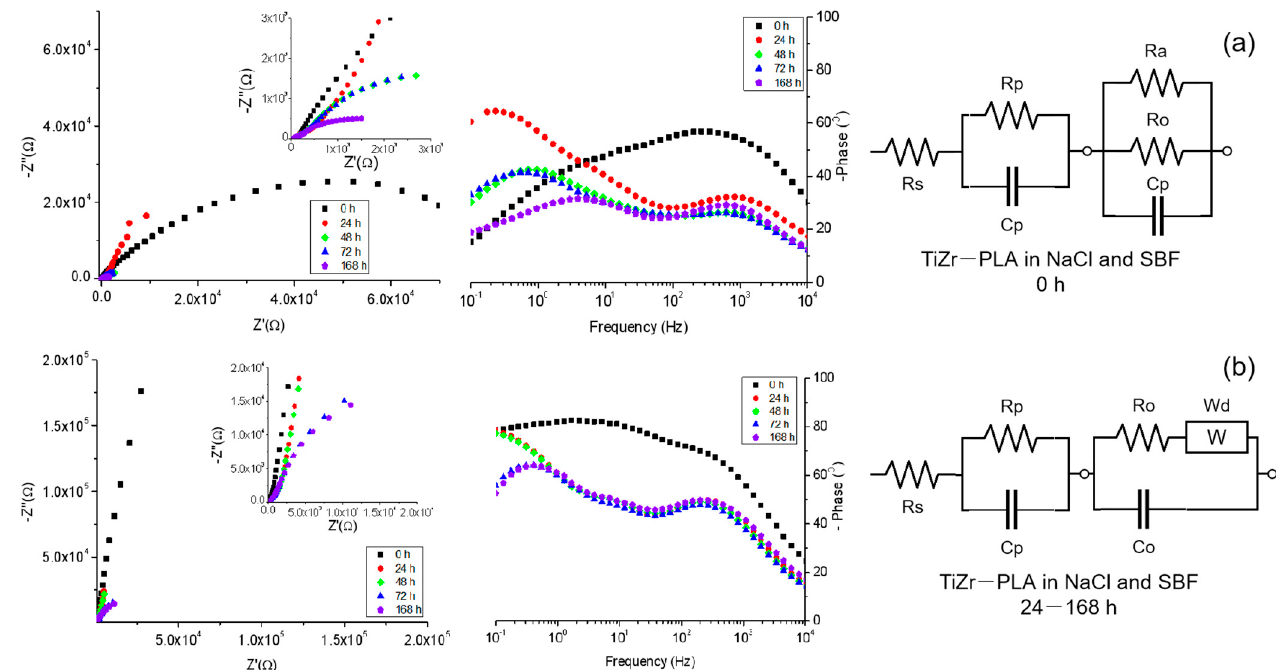
Figure 5. Nyquist, Bode Phase plots and equivalent circuits for TiZr covered with PLA nanofibers in ( a ) 0.9% NaCl; ( b ) SBF. Inset—Nyquist detail at high frequencies. Table 4. Equivalent circuit values for etched TiZr covered with PLA nanofibers in 0.9% NaCl and SBF.